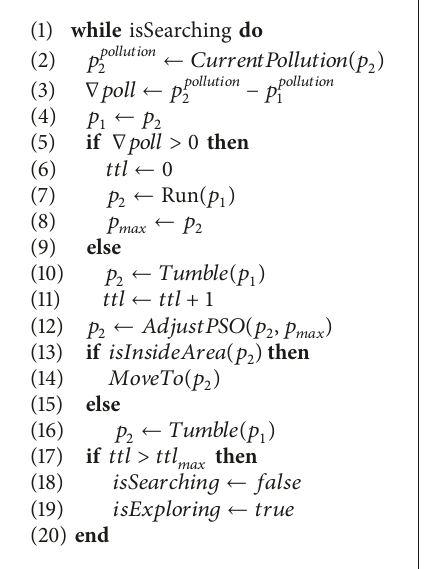
Algorithm 1: PdUC search phase.